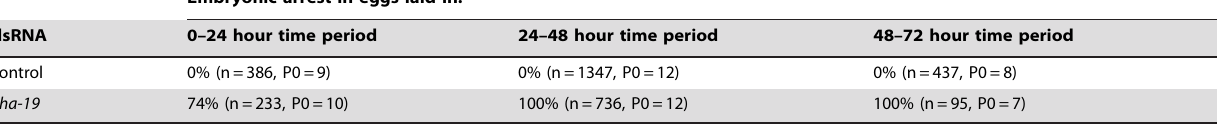
Embryonic arrest in eggs laid